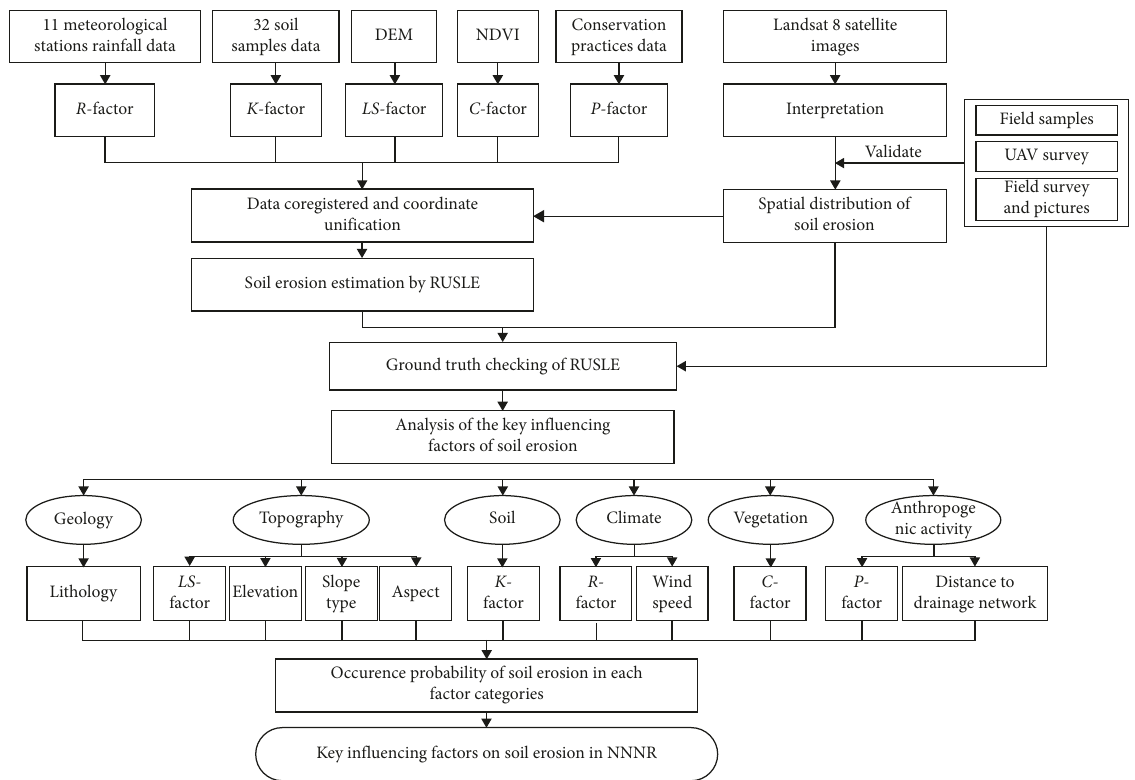
Figure 4: The methodology used in the